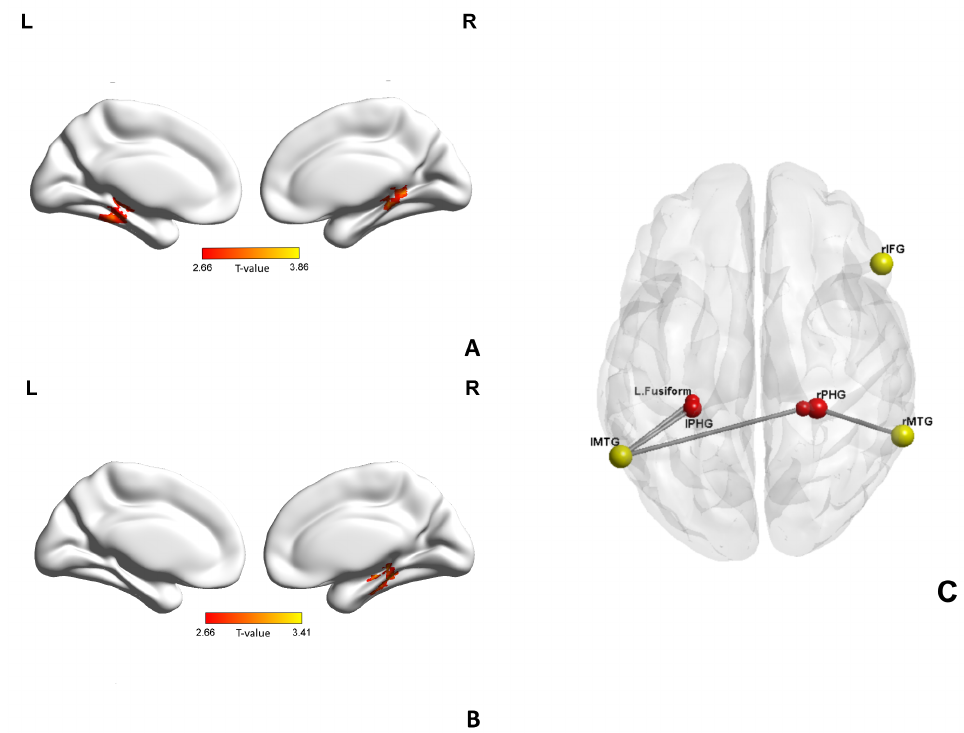
Figure 4. Results of psychophysiological interaction (PPI) analysis. ( A ) With the left middle temporal gyrus (MTG) as a seed, the patients with schizophrenia displayed increased functional connectivity between the left MTG and the left fusiform gyrus and the left parahippocampal gyrus (PHG). ( B ) With the right middle temporal gyrus (MTG) as a seed, the patients with schizophrenia displayed increased functional connectivity between the right MTG and the right PHG. ( C ) Overall PPI results. Seed regions are indicated as yellow